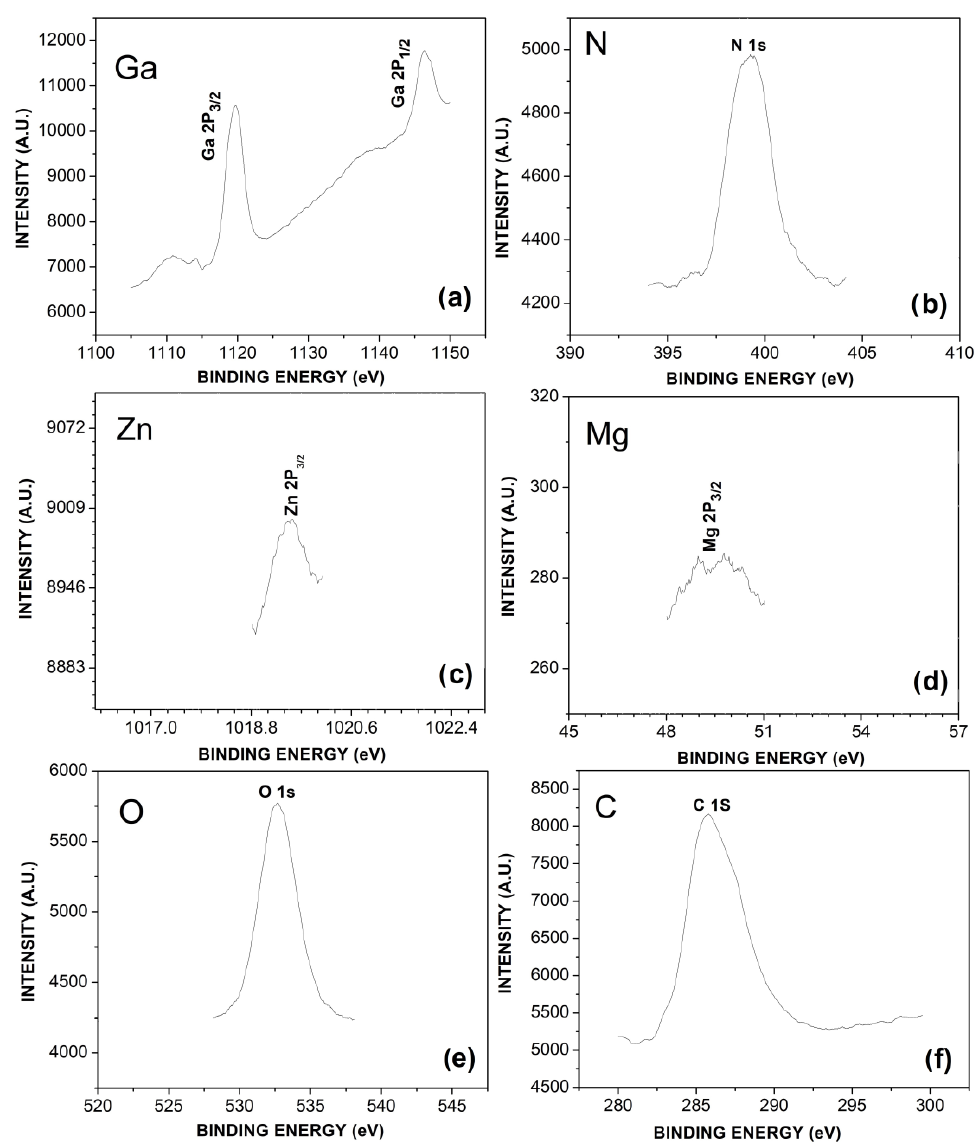
Figure 6. XPS spectra of the Mg-Zn co-doped GaN powders:( a ) Ga 2P 3/2 and Ga 2P 1/2 , ( b ) N 1s, ( c ) Zn 2P 3/2 , ( d ) Mg 2P 3/2 , ( e ) O 1s, and ( f ) C 1s peaks.